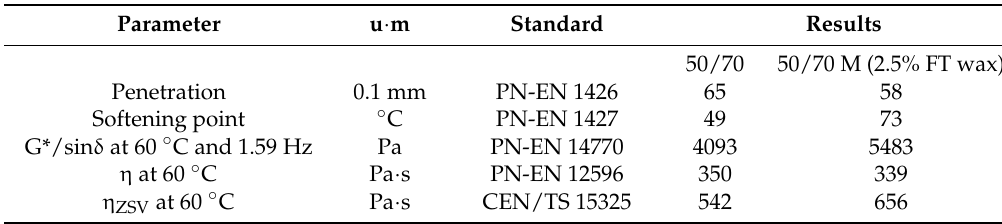
Table 1. Bitumen test